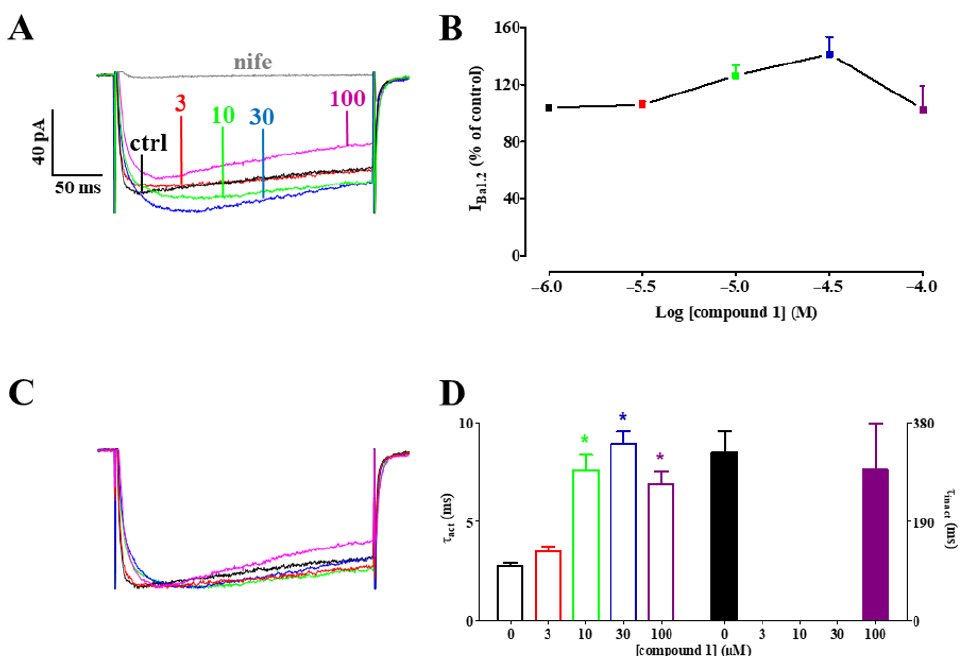
Figure 3. Effect of compound 1 on I Ba1.2 amplitude and kinetics recorded in rat tail artery myocytes. ( A ) Current traces (averaged from 5 cells) recorded with a clamp pulse to 0 mV from a V h of − 50 mV in the absence (ctrl) or presence of various concentrations (µM) of compound 1 . ( B ) Concentration-dependent effect of compound 1 . On the ordinate scale I Ba1.2 amplitude is reported as percentage of that recorded just before drug addition. Data points are means ± s.e.m. ( n = 4–6). ( C ) Current traces (shown in panel A) sized so that the peak amplitude of the traces in presence of the drug matched that of control. ( D ) Concentration-dependent effect of compound 1 on time constants of either current activation (τ act; open columns) or current inactivation (τ inact ; closed columns). Columns are means ± s.e.m. ( n = 5) * p < 0.05, repeated measures ANOVA and Dunnett’s post -test vs. control.